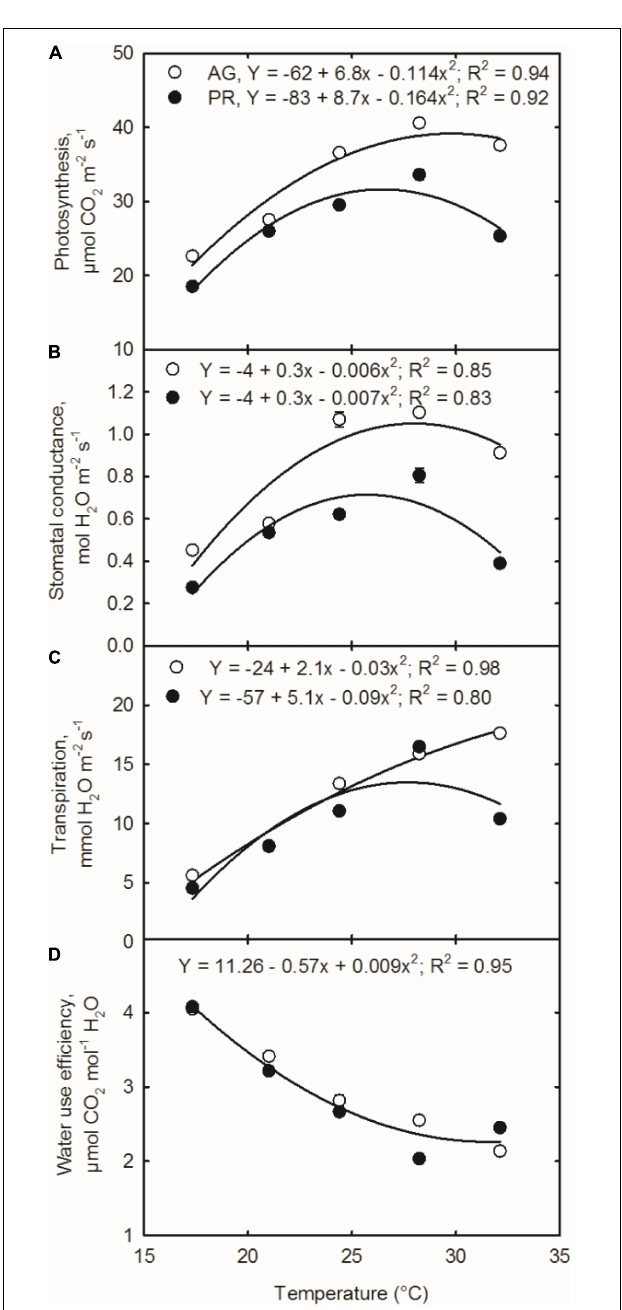
FIGURE 2 | Temperature effects on (A) photosynthesis, (B) stomatal conductance, (C) transpiration rate, and (D) water using efficiency of soybean cultivars [Asgrow AG 5332 (AG) and Progeny P5333 RY (PR)]. Measurements were taken 65 days after sowing and 27 days after temperature treatments. SEM ± four observations are presented if the values are larger than the symbol